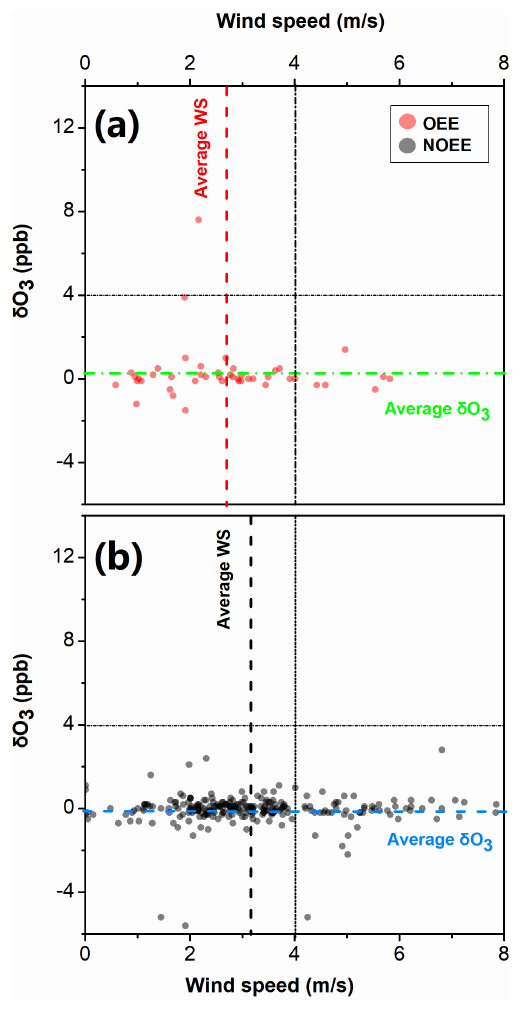
Figure 10. Wind speed and (cid:49) O 3 statistical distribution around OEEs (red dots) and NOEEs (black dots) at DA in the po- lar night. Here, (cid:49) O 3 represents the growth rate of near-surface O 3 concentration, calculated by the following equation: (cid:49) O 3 = the O 3 concentration at T n − the O 3 concentration at T n − 1 time difference between T n and T n − 1